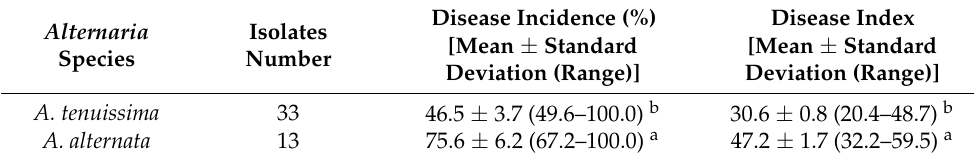
Figure 4. Pathogenicity of the 46 Alternaria isolates on healthy detached strawberry leaves of the variety “Dandong 99”. ( a ): inoculated with sterile water (control); ( b ): inoculated with A. tenuissima ; ( c ): inoculated with A . alternata . Table 2. Disease incidence and disease index values of 46 Alternaria isolates when placed on detached strawberry leaves.